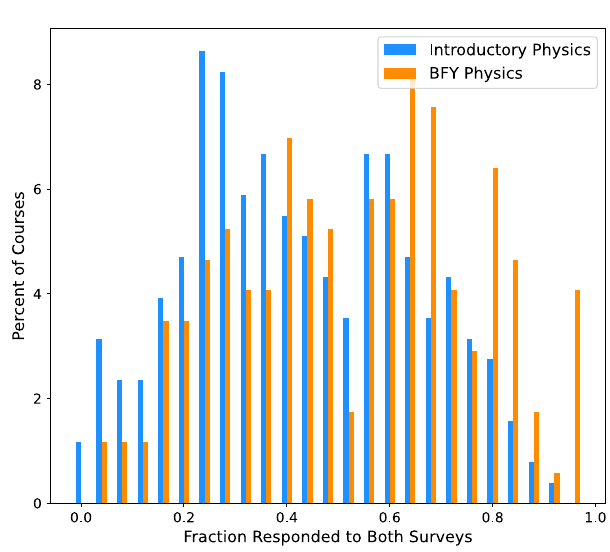
FIG. 3. The distribution of matched responses divided by the total number of unique responses from both pre- and postsurveys. The horizontal axis is calculated according to Eq.